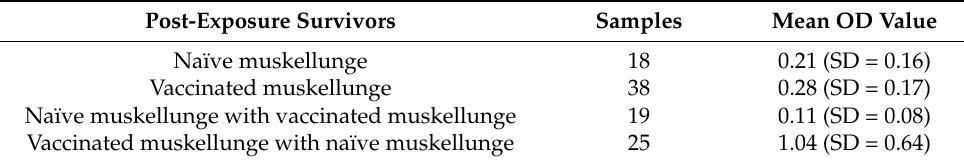
Table 3. Anti-VHSV-IVb antibodies following exposure. OD values indicating the presence of anti-VHSV-IVb antibodies in challenged muskellunge sera collected from muskellunge kept at different housing combinations at the termination of cohabitation Trials 4, 5, 6 and 8. The mean OD values were determined using an indirect enzyme-linked immunosorbent assay (ELISA) and were calculated by averaging over survivors within individual tanks and then averaging across